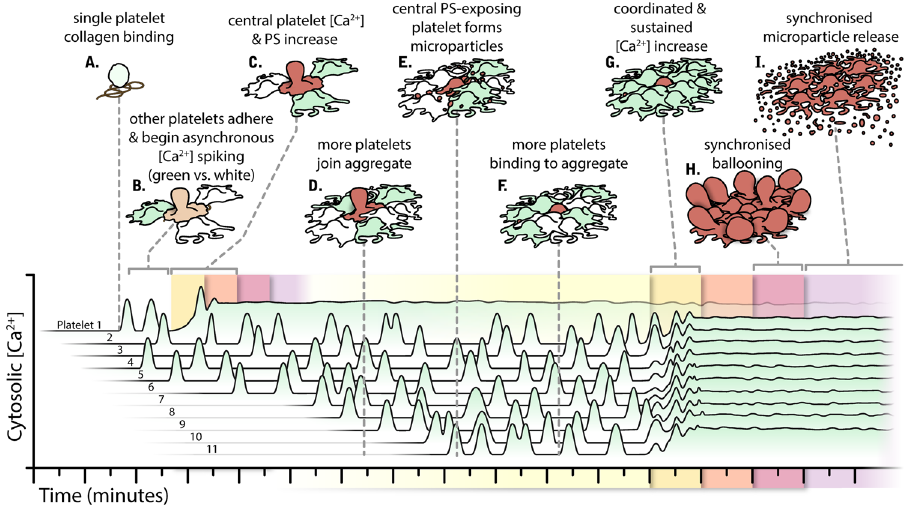
Figure 7. Synchronous membrane ballooning in human platelet-rich plasma in vitro . In this model, platelets adhere to collagen upon vessel injury ( A ), and undergo primary procoagulant membrane ballooning ( B – D ) without synchronising individual calcium fluxes. These platelets bind the prothrombinase complex to support an initial localised thrombin formation ( E–G ), which diffuses to activate peripheral platelets and induce synchronised secondary membrane ballooning at the outer layer of the thrombus ( H ). Due to the action of thrombin on PAR1 receptors, this dramatic morphological event is preceded by the synchronisation of the cytosolic calcium flux in the individual platelets of the formed aggregate. The result is a subsequent rapid increase in the number of ballooned platelets and a surge in the number of platelet-derived microvesicles ( I ). This leads to a rapidly amplified but coordinated generation of more thrombin to stabilise the haemostatic response through coagulation. The image was conceptualised and outlined by the authors, and then drawn by ScideLight illustrations